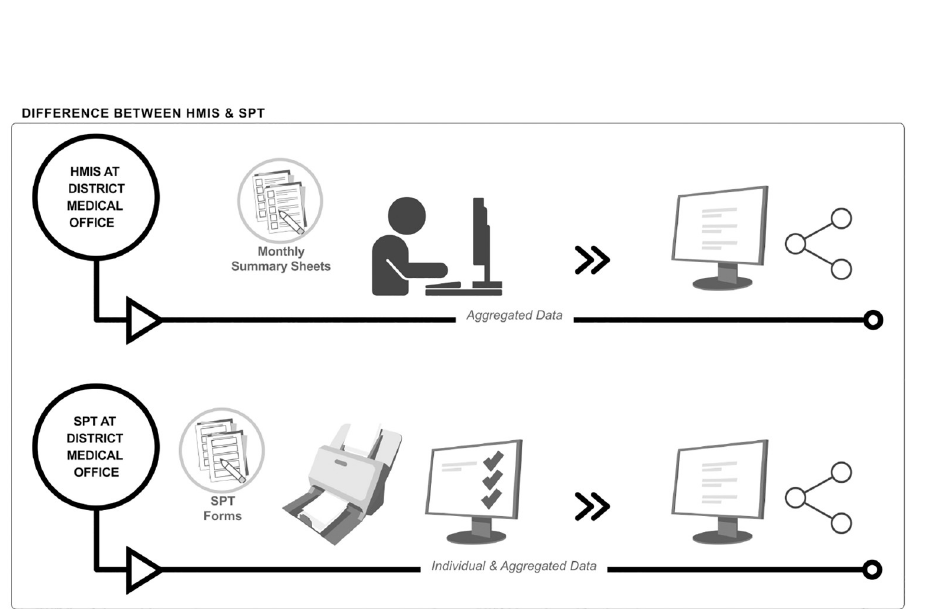
Fig 2. The difference between HMIS and SPT systems at district level. HMIS: Several health care managers manually enter information from monthly report forms of all health facilities into the electronic DHIS2 system. Obvious inconsistencies or errors detected during data entry are followed up by phone or during physical visits where registers are checked. In DHIS2 aggregated data can be viewed from facilities with paper-based data entry (dispensaries) and both individual and aggregated data from fully digitized data entry (many health centres and all hospitals). SPT: One scanning officer scans all forms per facility. Data is automatically read by the software. Inconsistencies or errors are flagged by the system. A data verification officer works on these using the electronic register and phone calls to facilities if needed. Daily tally sheets and monthly summary reports are created automatically. Individual and aggregated data can be viewed.